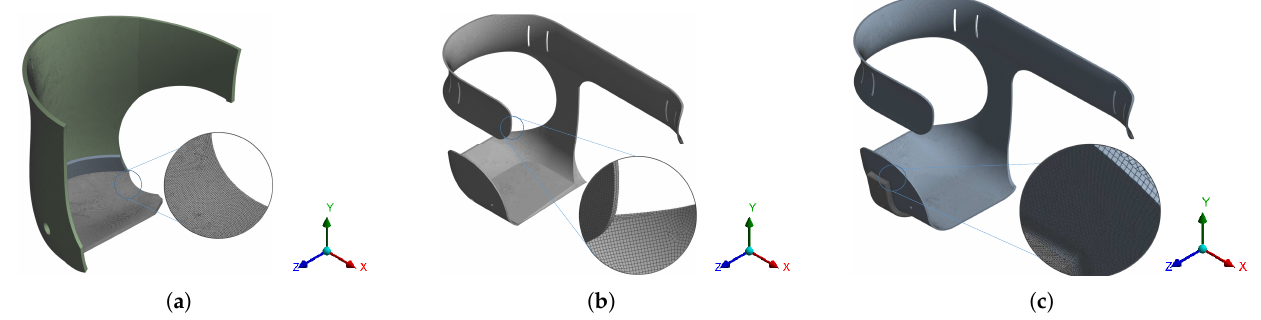
Figure 4. Meshing of the models presented in this work: ( a ) Model 1; ( b ) Model 2; ( c ) Model